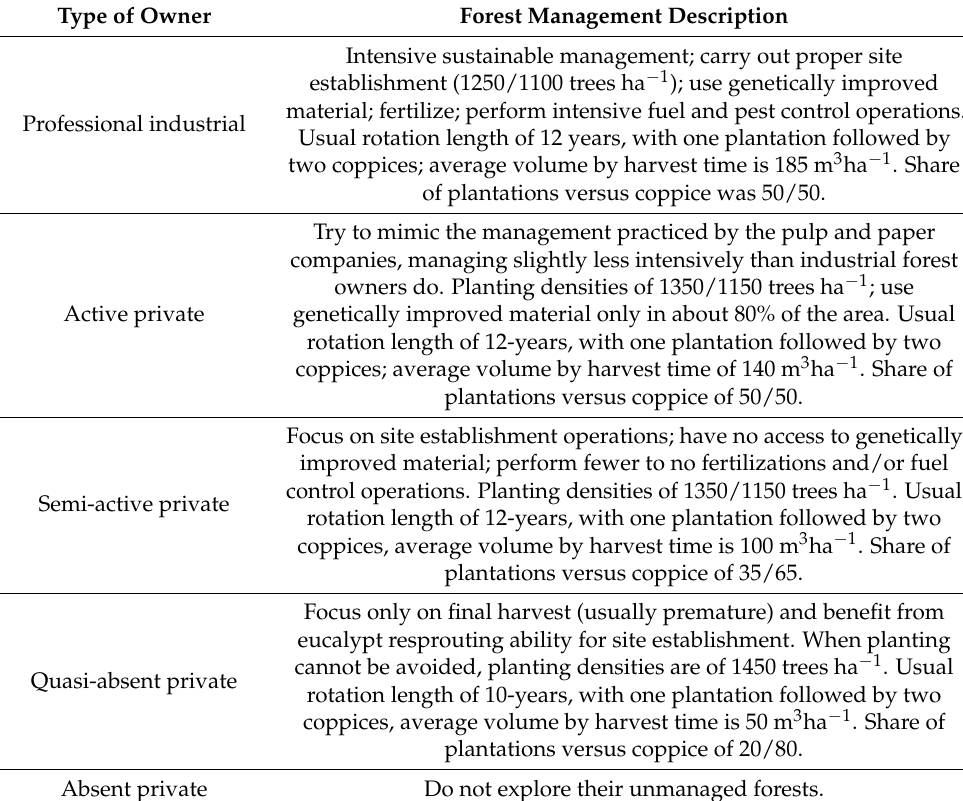
Table 1. Forest owner type and management